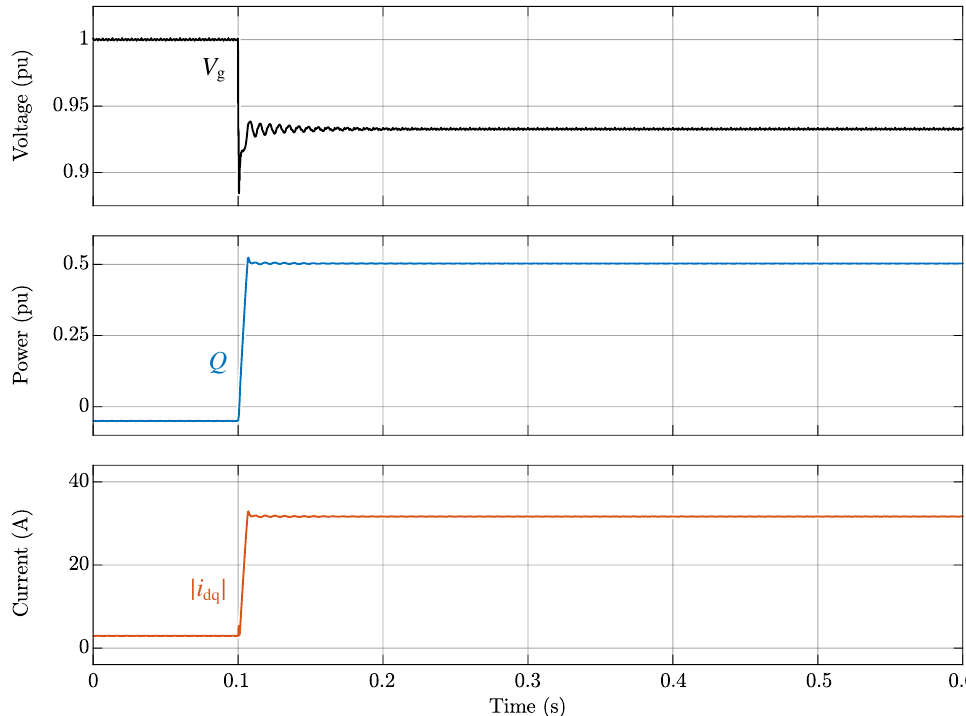
Figure 18. Simulated D-STATCOM response to a 10% permanent voltage dip: the injected current remains constant after the